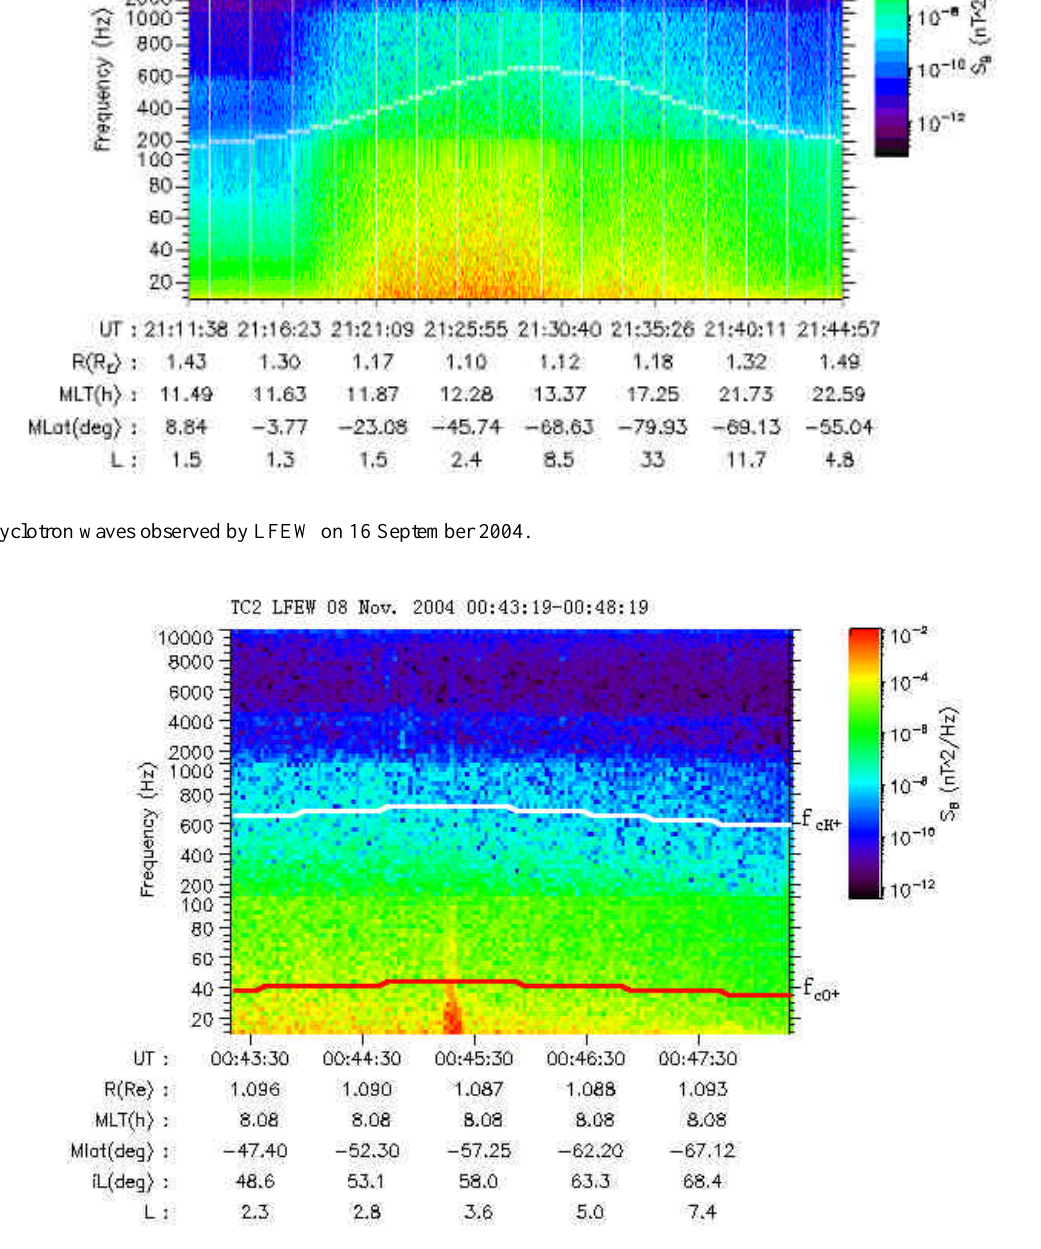
the waves become stronger than at the entry. The profile of the wave frequency spectrum seems to have a close relation with the proton cyclotron